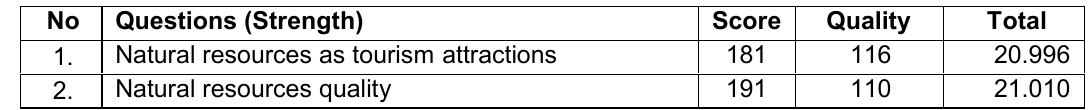
Table 3. Quantitative evaluation for Internal